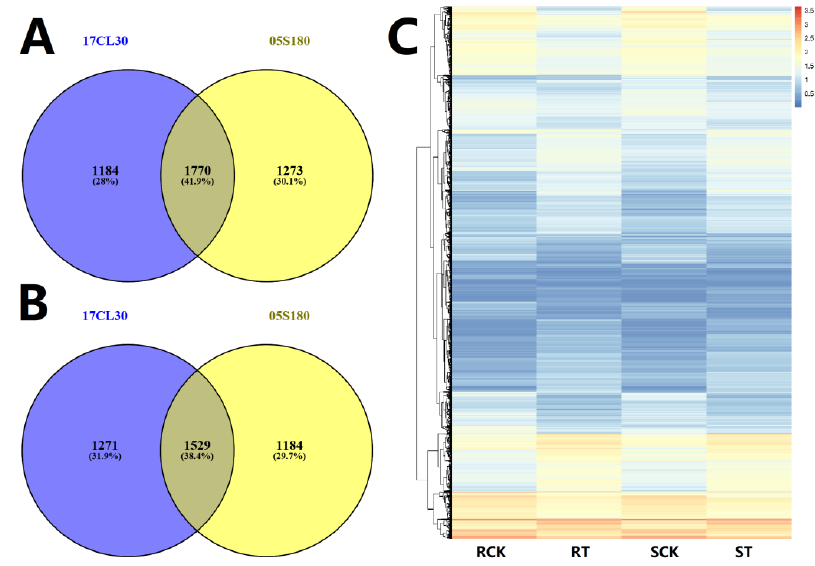
Figure 3. Analysis of transcriptome data. ( A ) Venn graph for 17CL30 (heat-tolerant cultivar) and 05S180 (heat-sensitive cultivar) of heat-induced genes. ( B ) Venn graph for 17CL30 and 05S180 of heat-repressed genes. ( C ) Heatmap of di ff erentially expressed genes (DEGs) in RCK, RT, SCK, and ST. RCK refers to the control group of the 17CL30, RT refers to the heat treatment group of 17CL30, SCK refers to the control group of 05S180, ST refers to the heat treatment group of